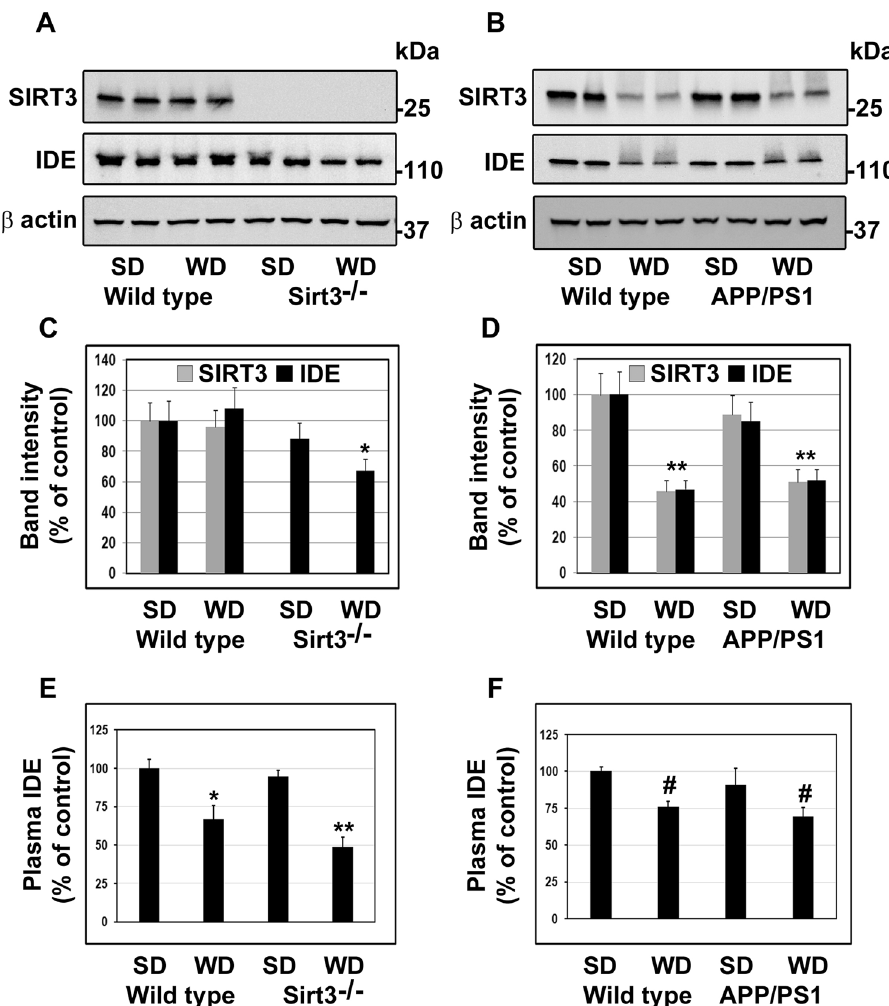
Figure 5. Effects of calorie overload on the levels of SIRT3 and IDE. Two-month-old male wild type and Sirt3 -/- mice were fed a standard diet (SD) or western diet (WD) for 4 months ( A , C and E ). 6 weeks-old Wild type (WT) and APP/PS1 male mice were fed on standard diet (SD) or energy-rich western diet (WD) for 7 months ( B,D and F ). Mouse cortical samples from the four groups of mice were collected for the Western blot analysis of SIRT3 and IDE ( A , B ). Representative cropped images are presented for clarity and conciseness while the composite color images of full blots are presented in Supplementary Figure. The band intensities were determined by scanning, corrected for β actin levels, and expressed as percent of control. ( C , D ). Plasma was separated from the collected blood samples for the assay of IDE by ELISA ( E , F ). Data are expressed as mean of ± SE (n = 6) for each group. #, P < 0.05; *, P < 0.01; **, P < 0.001 versus WT mice on standard